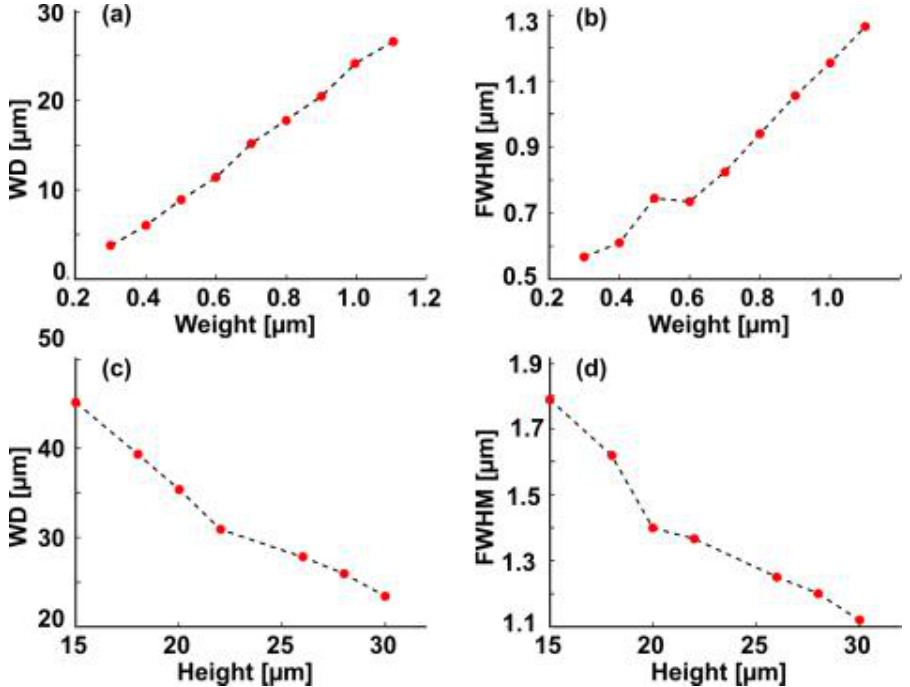
Figure 4. Working distance W D ( a , c ) and FWHM ( b , d ) variations as a function of Bézier weight ( a , b ) and height ( c , d ) of the shaped tip for the 20/125 fiber ( NA = 0.22). Default value: D = 32 µm, h = 26 µm and W 0 =